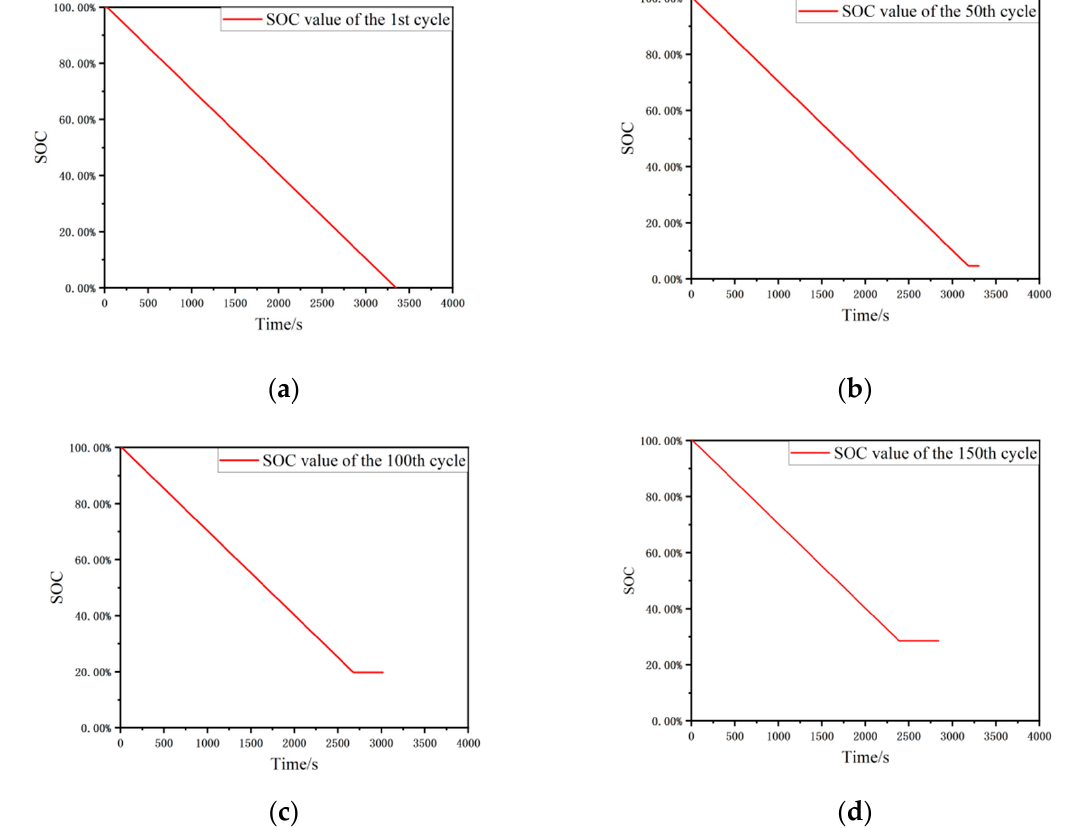
Figure 1. Results of the SOC estimation of the traditional ampere-hour integral method. ( a ) Estimation results of the SOC during the charging process of the No.5 battery in the 1st cycle. ( b ) Estimation results of the SOC during the charging process of the No.5 battery in the 50th cycle. ( c ) Estimation results of the SOC during the charging process of the No.5 battery in the 100th cycle. ( d ) Estimation results of the SOC during the charging process of the No.5 battery in the 150th cycle.